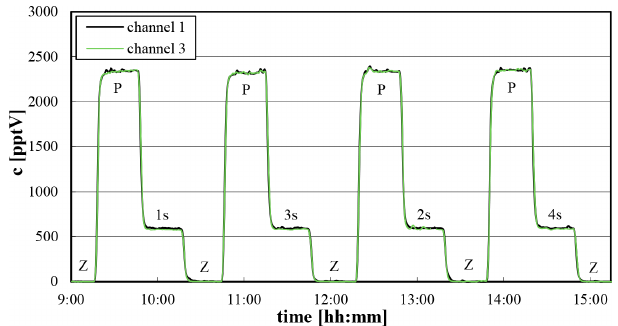
Figure 4. HONO mixing ratios during test measurements using a pure HONO source and variable valve switching times (30s